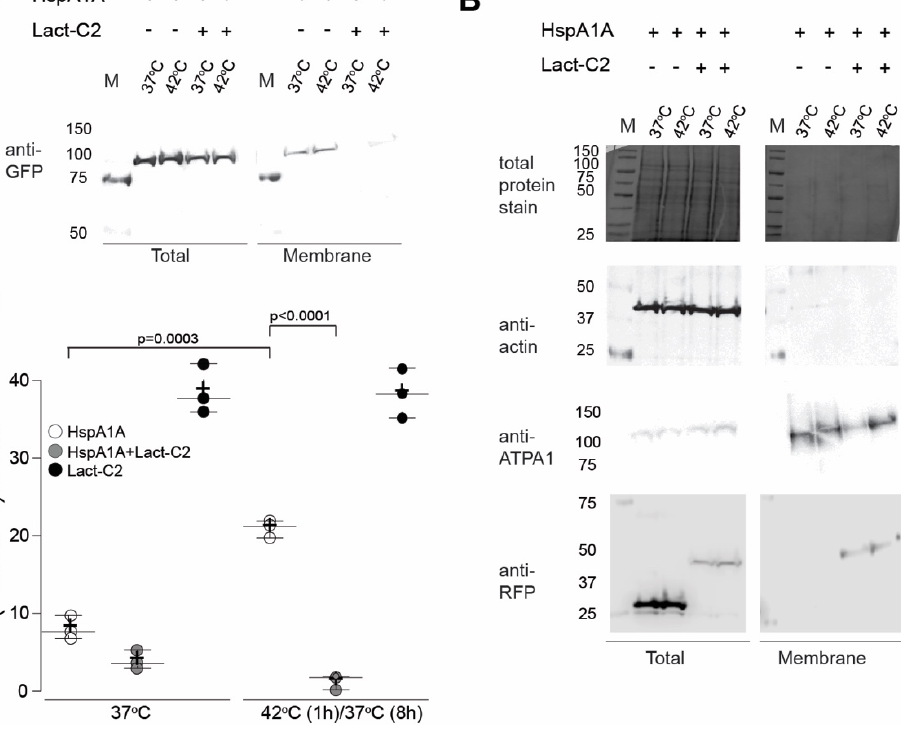
Figure 5. Cell surface biotinylation reveals that HspA1A’s PM-localization depends on its binding to PS. ( A ) Representative Western blots showing the total and biotinylated fractions of HEK293 cell lysates transfected with HspA1A-GFP and RFP-C1 vector, and HspA1A-GFP and Lact-C2-mCherry. The antibody used was the OmicsLink ™ Anti-GFP Tag Antibody Mouse Monoclonal IgG1 ((CGAB-GFP-0050); 1:1000); ( B ) The nitrocellulose membranes used in ( A ) were stained with the Reversible Protein Stain Kit (Pierce) and were also blotted with the control antibodies listed below. The antibodies used were the Beta Actin, Clone: 13E5, Cell Signaling ((Rabbit mAb #4970) 1:1000); Na +/ K + ATPase α (ATP1A1) antibody RabMAb ® ((EP1845Y); (2047-1); 1:1000); and RFP Tag Monoclonal Antibody (RF5R) ((MA5-15257); 1:1000)). M: molecular size marker (BioRad Dual Color Protein Ladder; approximate sizes shown on the left side of the blots). ( C ) Quantification of the antibody detected signals of the HspA1A (GFP tagged) in the presence or absence of Lact-C2, as well as the Lact-C2 (mCherry tagged) presented as a ratio between the biotinylated (PM) fraction and the total cell lysate. Densitometry values are averages of three independent experiments ( n = 3). Center lines show the medians; whiskers extend 1.5 times the interquartile range from the 25th and 75th percentiles; crosses represent sample means. The P values of the student t -test were: HspA1A-37 / HspA1A-42 = 0.003; HspA1A-42 / HspA1A-42-LactC2 < 0.0001; HspA1A-37-LactC2 / HspA1A-42-LactC2 = 0.0413; HspA1A-37 / HspA1A-37-LactC2 = 0.0212.